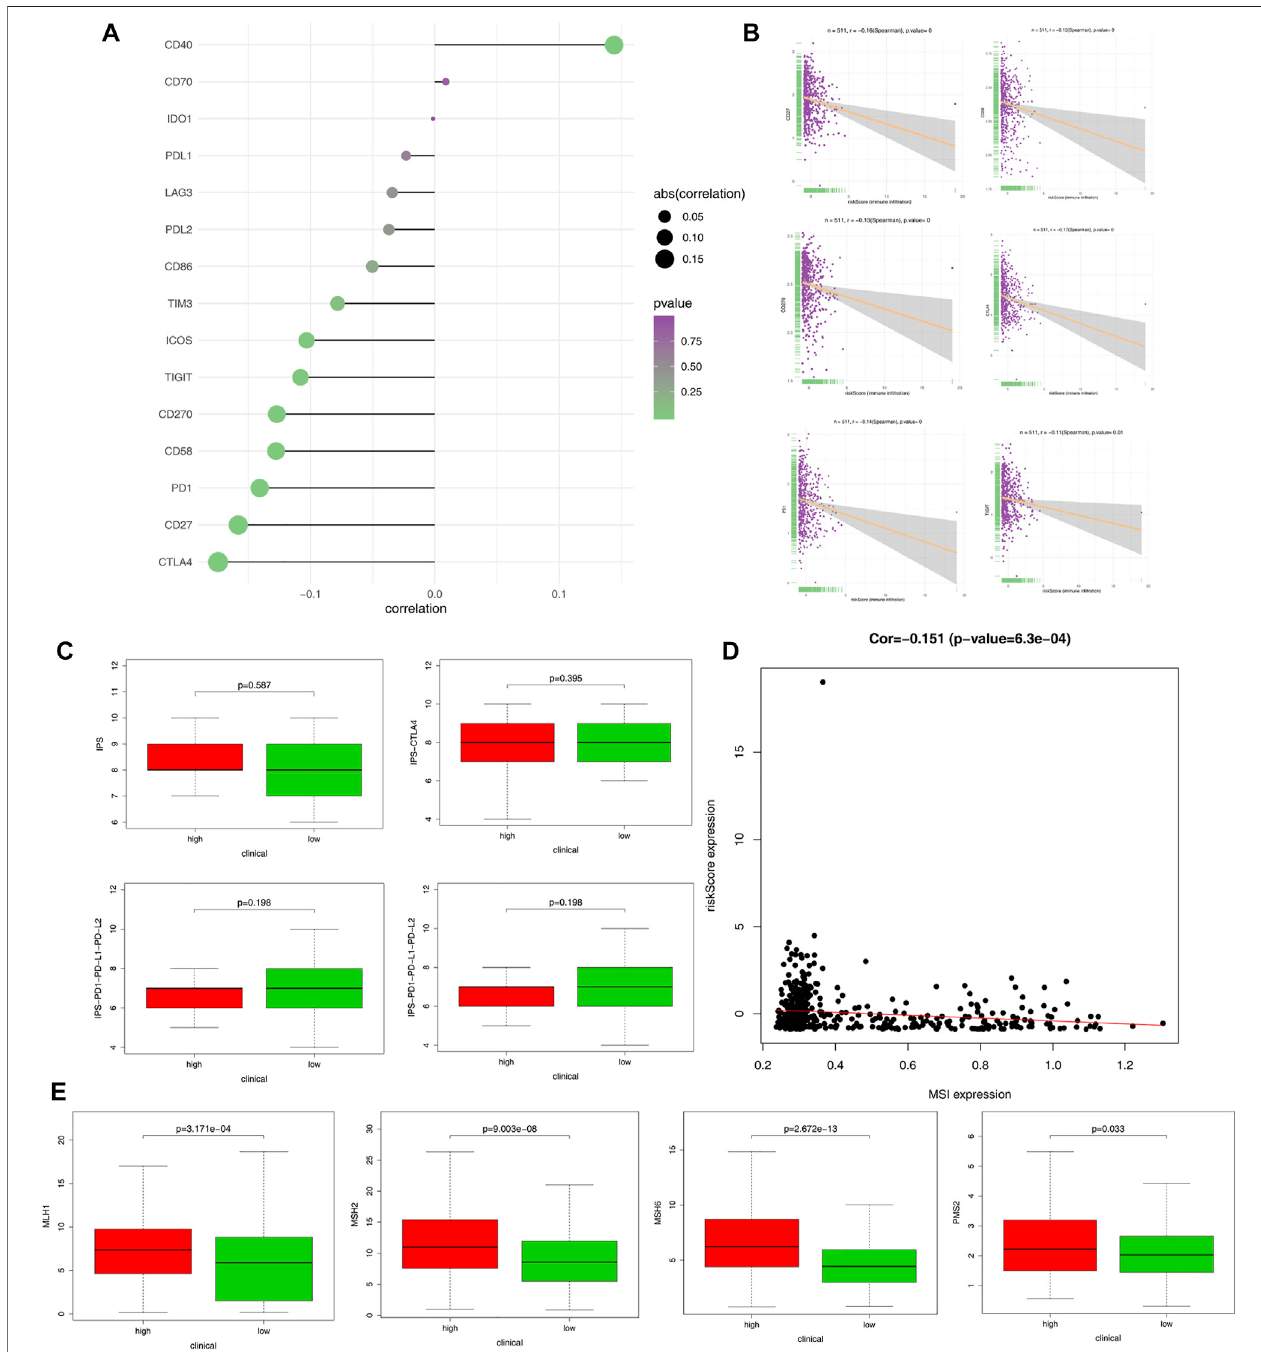
FIGURE 7 | Immunophenoscore (IPS) score and gene expression analysis of immune checkpoint. (A) Correlation of risk score and expression of ICI related genes. (B) Correlation of CD27, CD58, CD270, CTLA4, PD1, TIGIT, and risk score. (C) Expression level of IPS, IPS-CTLA4, IPS-PD1-PD-L1-PD-L2, and IPS-PD1-PD-L1-PD-L2-CTLA4 in the high- and low-risk groups of patients with endometrial cancer. (D) Negative correlation between immune-related risk score and microsatellite instability (MSI). (E) The gene expression of MLH1, MSH2, MSH6, and PMS2 in the high- and low-risk groups.